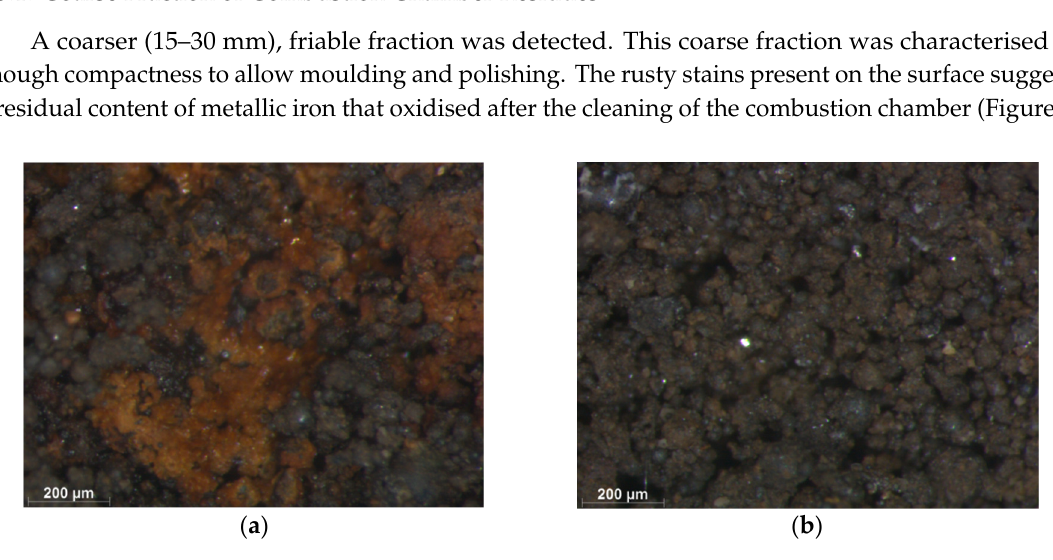
Figure 9. Stereomicrographs of as-received coarse combustion chamber residues with ( a ) and without ( b ) visible rusty stains.